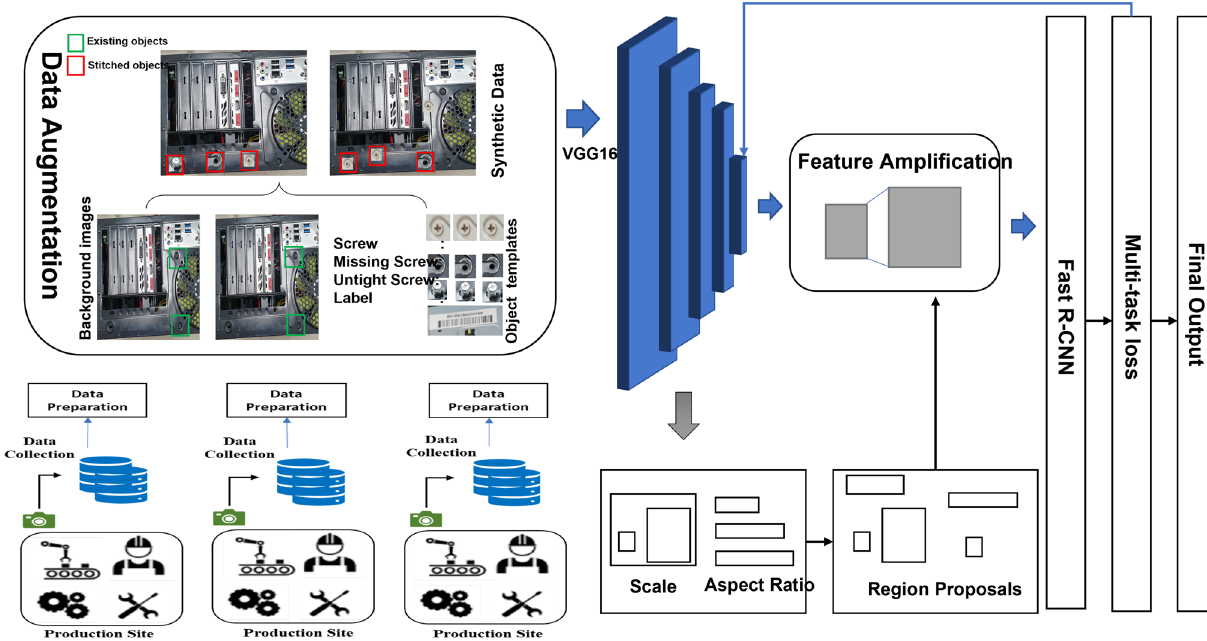
Figure 1. Detailed overview of the proposed